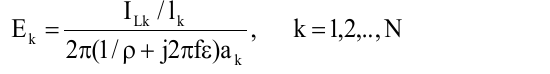
Figure 2: (a): Ionization phenomenon around the conductor, and (b): ionization model as gradually increasing radius. Adapted from [8].